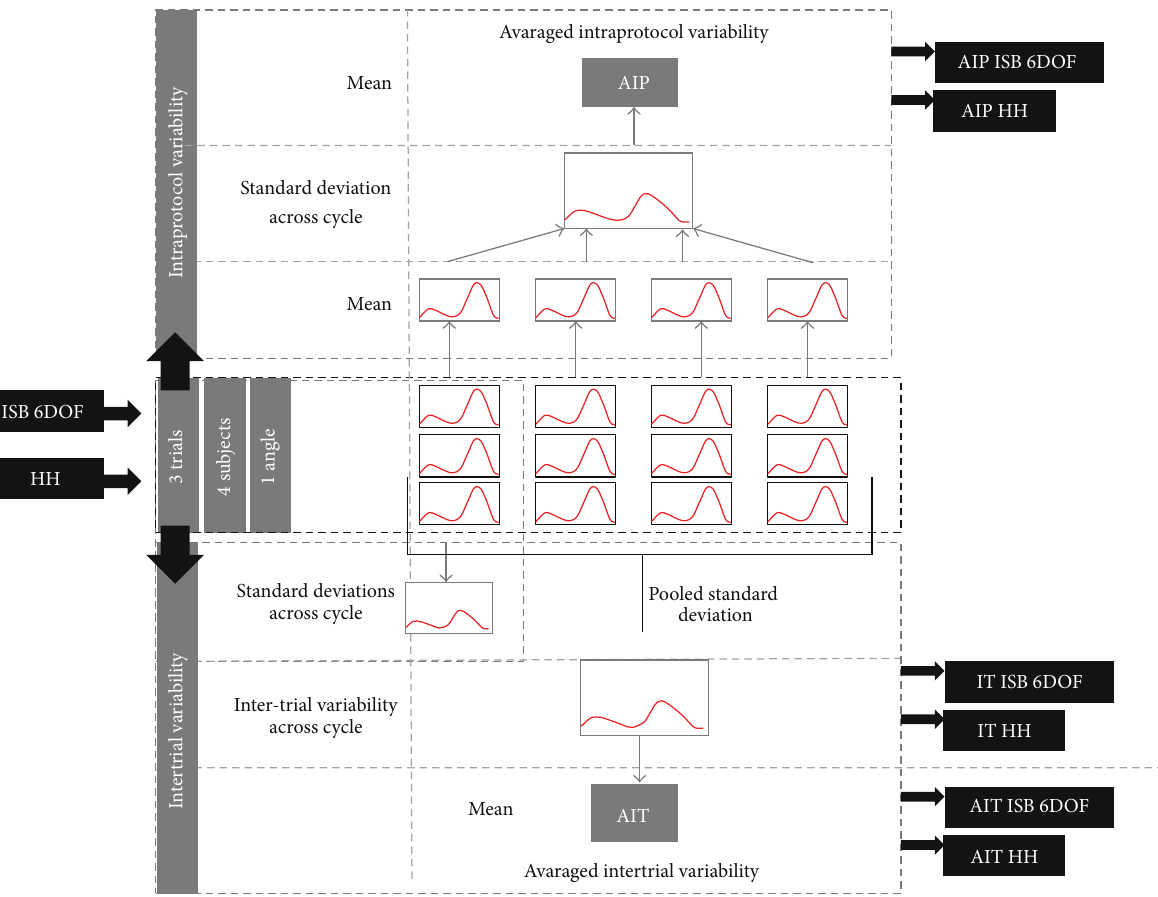
Figure 3: Scheme of the data processing procedure. Four healthy subjects were examined using two different protocols (ISB 6DOF, HH), three trials were selected. Averaged intraprotocol variability (AIP) and averaged intertrial variability (AIT) were calculated, intertrial variability across cycle (IT) was plotted for both protocols.